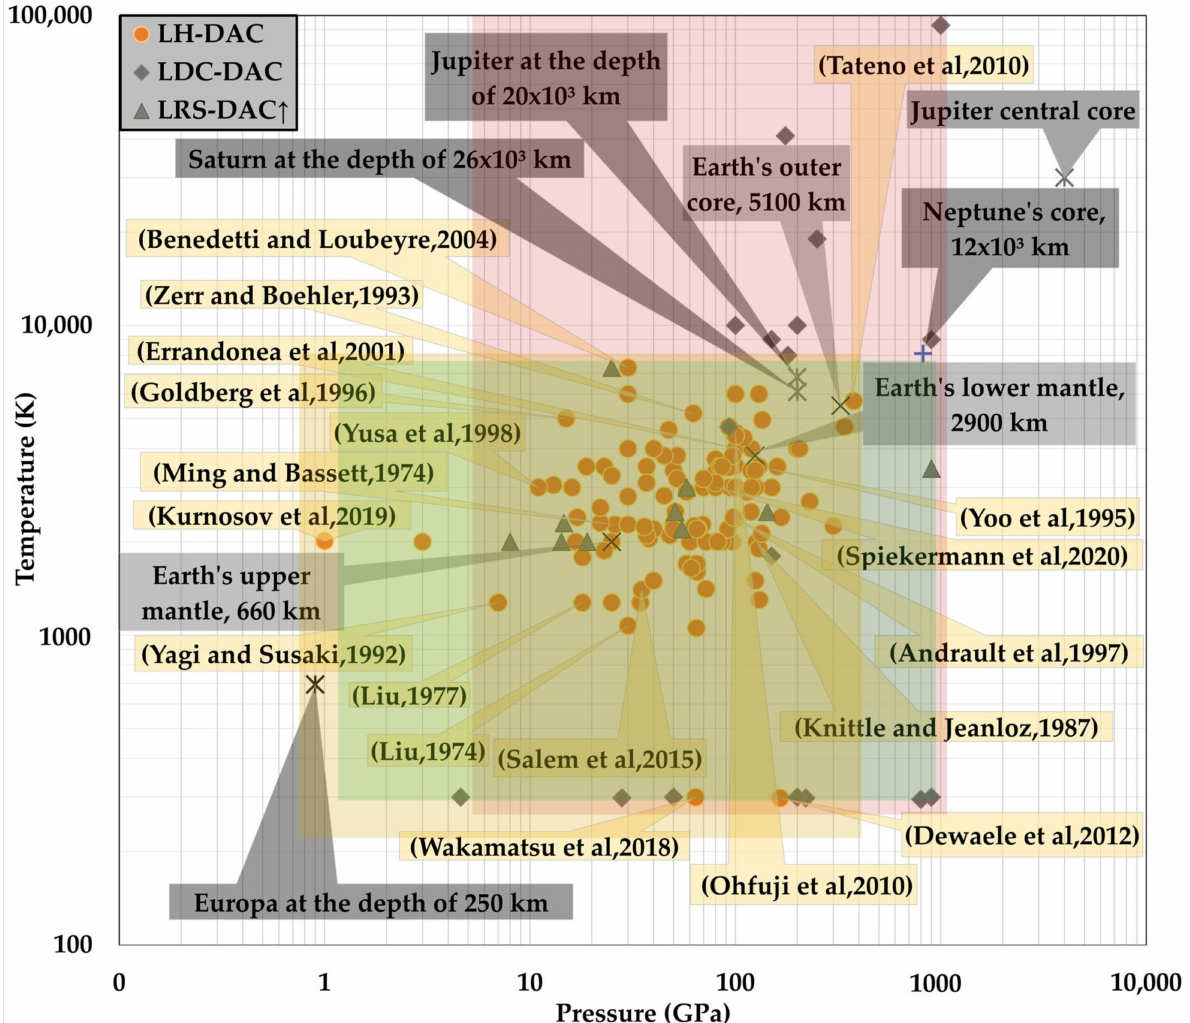
Figure 4. P-T Map of L-DAC experiments, showing regions explored by (A-Orange) LH-DAC systems [5,17,19,29,30,32,35–37,42,43,66–68,71,72,75,112–114,116,118–214], (B-Red) LDC-DAC sys- tems [26,44,45,215–219], and (C-Green) LRS-DAC operations [3,20,23,51,220–223], in comparison to the temperature-pressure regions 250 km down in Europa’s oceans [224], 660–5100 km below the Earth’s surface [26,67,144], 12 × 10 3 km deep in Neptune core [225], Saturn at the depth of 26 × 10 3 km [226], and 20 × 10 3 km deep in Jupiter’s atmosphere [227]. Values shown are at the peak pressures and temperatures provided in the respective